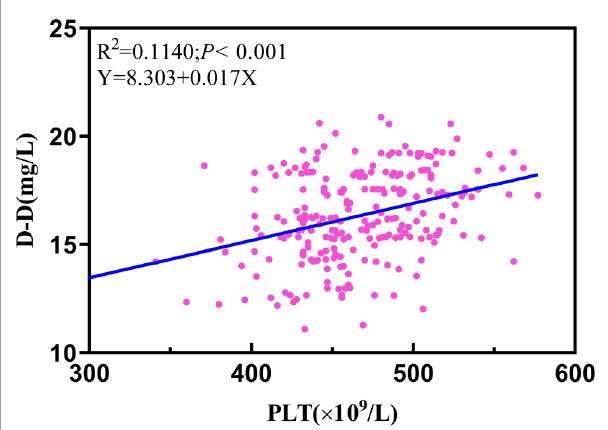
FIGURE 6 | Linear regression analysis performed in the plasma of PLT and D-D. 14th D-D: postoperative 14th day of D-dimer; 7th PLT: postoperative 7th day of platelet